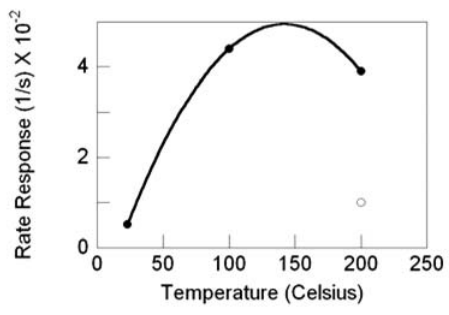
nanofiber sensor response rate versus temperature, filled circles are with Figure 26. SnO 2 Pd catalyst, the nonfilled circle is without